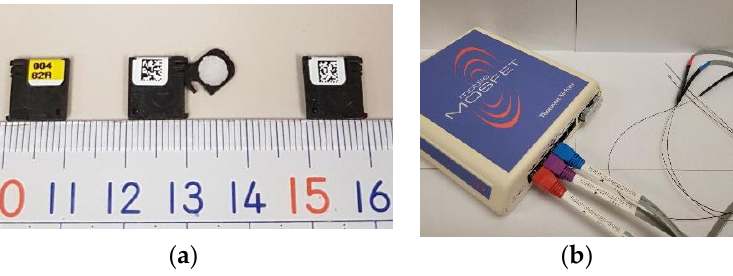
Figure 2. Optically-stimulated luminescence dosimeter (OSLD) and metal-oxide-semiconductor field-effect transistor (MOSFET) system. ( a ) A nanoDot TM shown to display its lot number face in closed position ( left ), QR code face in open position ( middle ), and QR code face in closed position ( right ); ( b ) An image of a mobileMOSFET single channel dosimeter system with three of the five channels